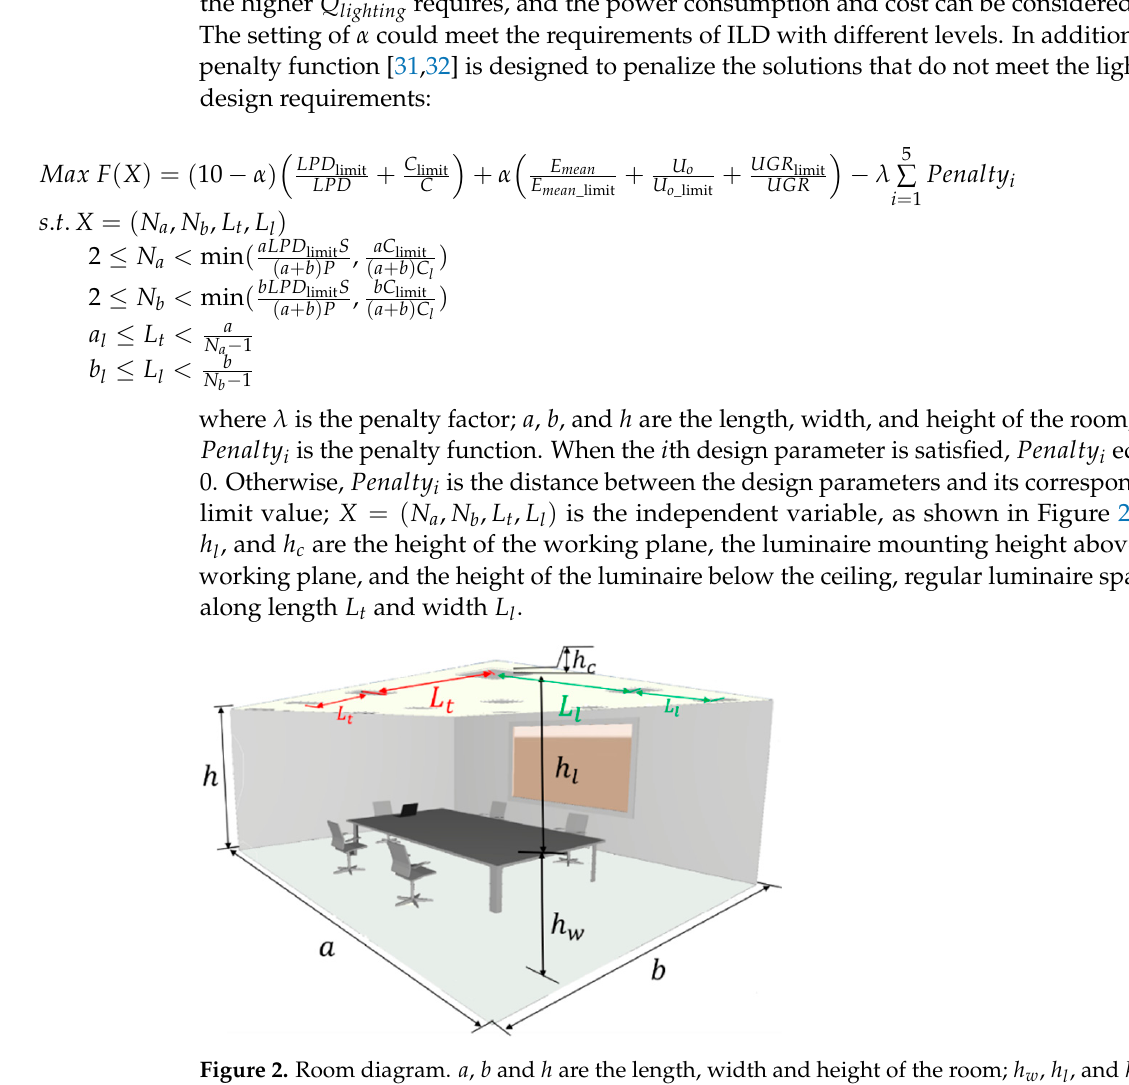
a b h , and are the length, width and height of the room; w Figure 2. Room diagram. the height of the working plane, the luminaire mounting height above the working plane, and the height of the luminaire below the ceiling, regular luminaire spacing along length L t and width L l . Other limitations of design parameters can be determined in Table 1. However,